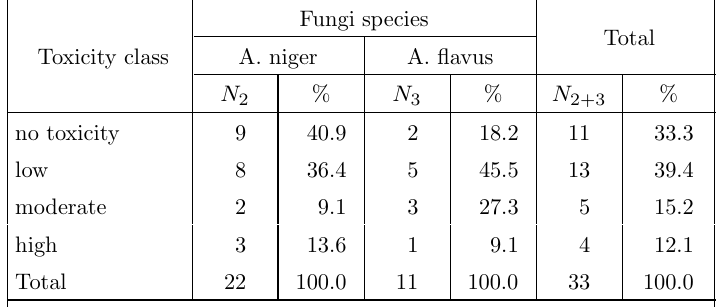
Table 3. Frequencies of the toxicity classes of only two fungi under study